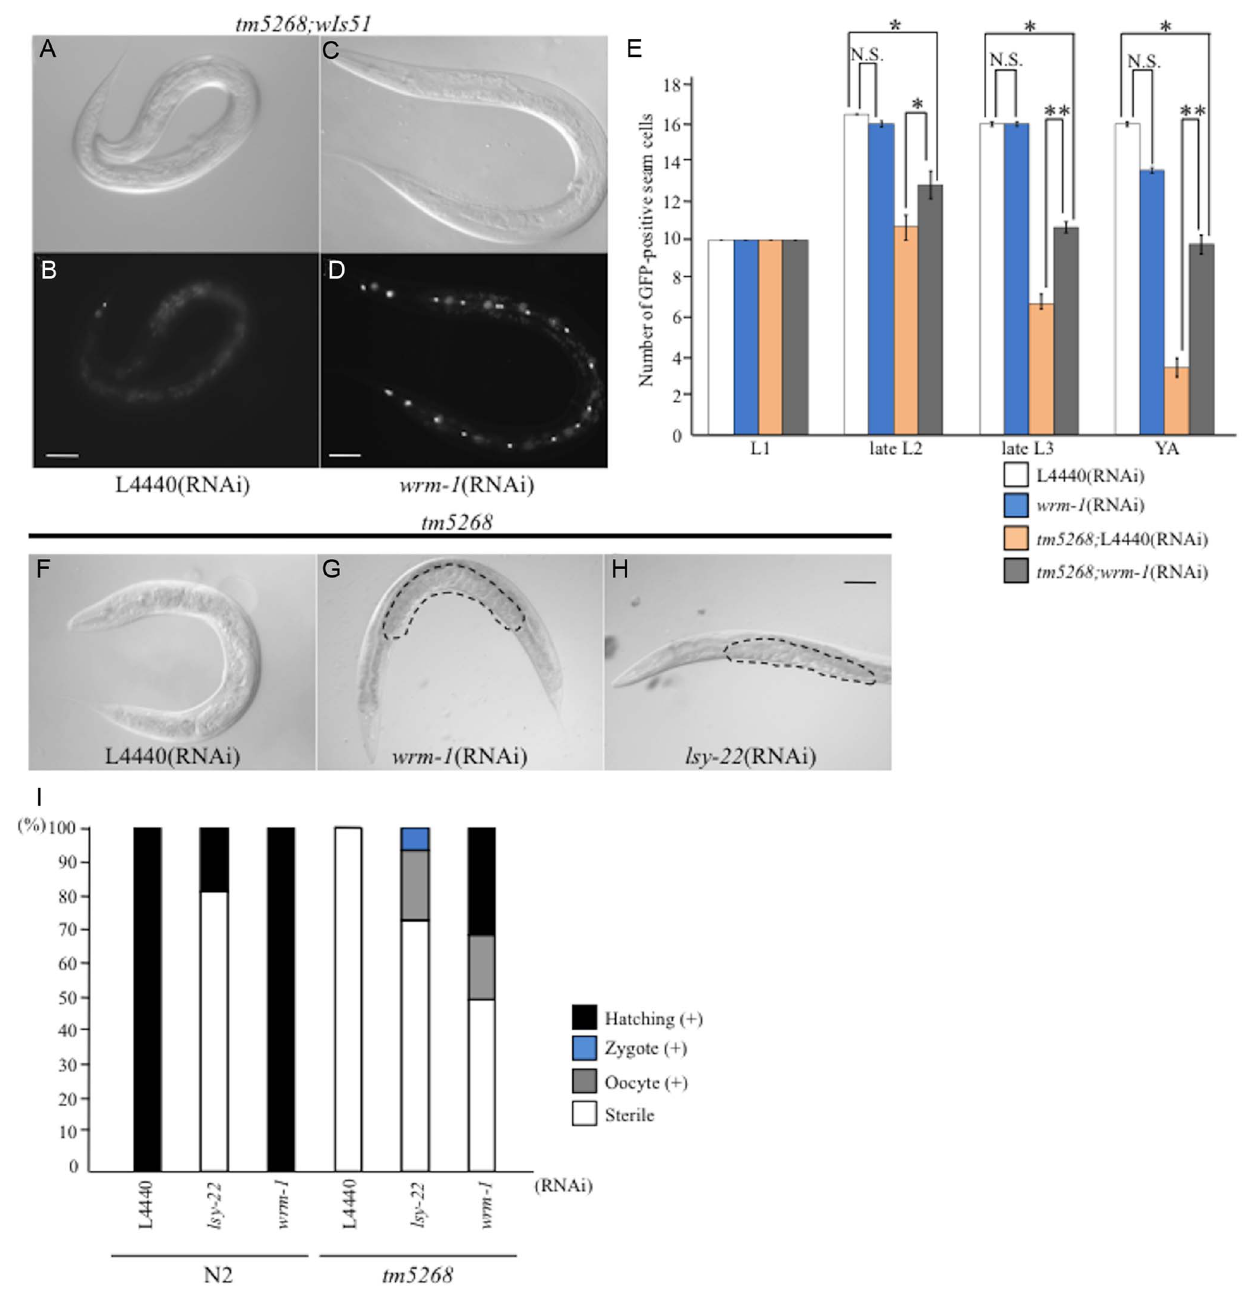
Fig. 4. Downregulation of wrm-1 or lsy-22 suppresses the phenotypes of bcl-7 mutants. A–D : Nomarski ( A, C ) and GFP images ( B, D ) of tm5268 adult hermaphrodites carrying an scm::gfp reporter treated with empty vector (L4440) ( A, B ) or wrm-1 -specific RNA ( C, D ). E : Bar chart representing the average number of seam cells in wild-type, tm5268 , tm5268 ;L4440 (RNAi), or tm5268 ; wrm-1 (RNAi) hermaphrodites at the L1, late L2, late L3, or young adult stages. F–H : Nomarski images of tm5268 treated with L4440 (RNAi), wrm-1 (RNAi), or lsy-22 (RNAi). Eggs in the uterus are outlined with dotted lines ( G, H ). I : Percentages of the Ste phenotypes in wild-type and tm5268 adult hermaphrodites treated with L4440 (RNAi), wrm-1 (RNAi), or lsy-22 (RNAi). Numbers of examined animals were more than 60 for all strains.Error bars indicate SEM. Asterisks indicate statistical significance. *p , 0.05. **p , 0.005. N.S.: no significance. Scale bar =50 m m.